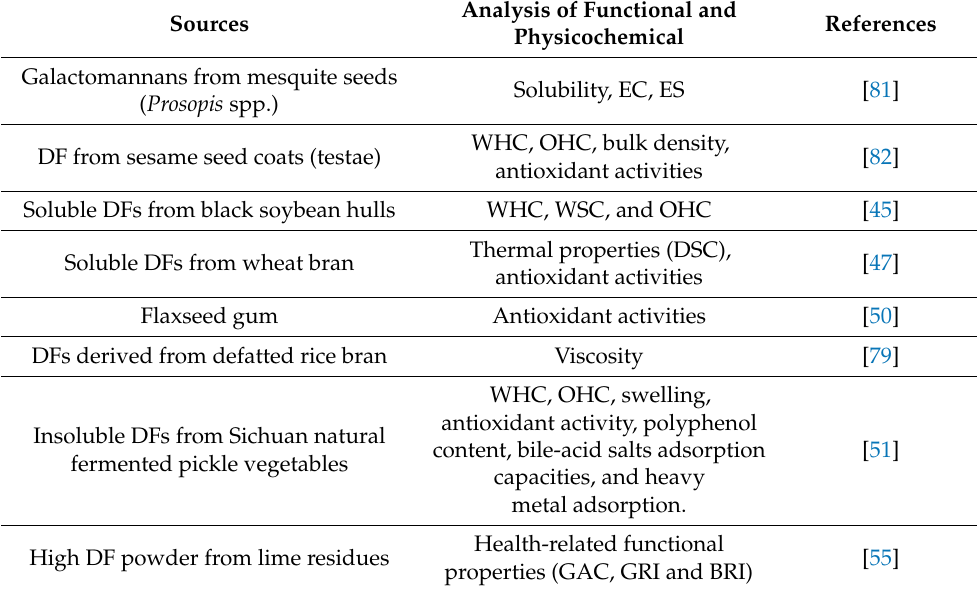
Table 2. Functional and physicochemical characterization of